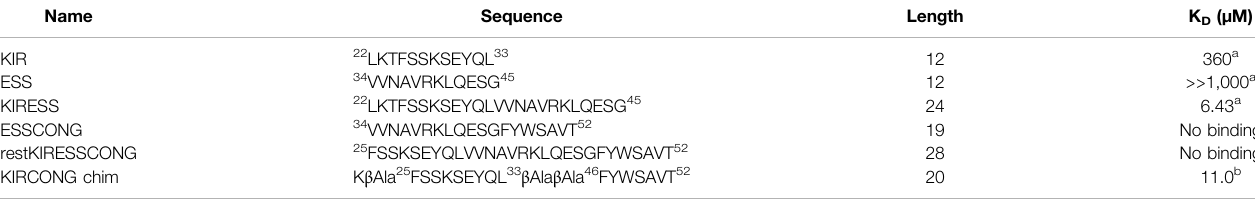
TABLE 3 | SOCS3 proteomimetics: name, sequence, length, and dissociation constants values (µM) toward JAK2 catalytic domain. Name